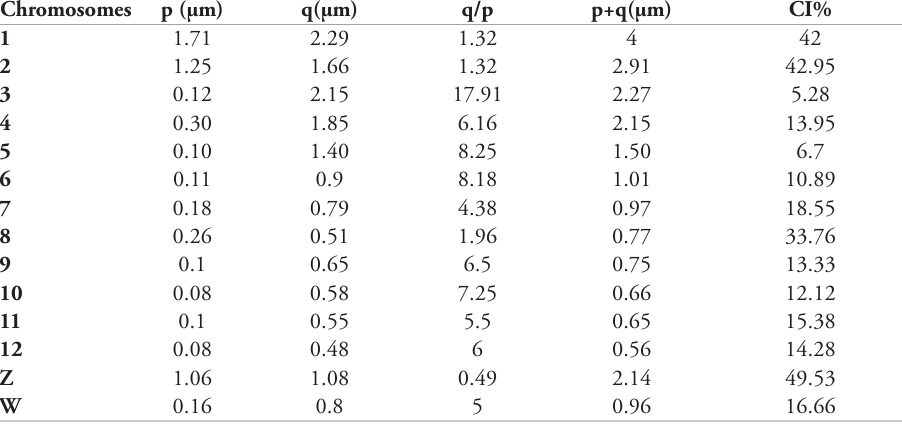
Table 1. Size of the mitotic chromosomes of the Common quail Coturnix coturnix (n=14) p: short arm,